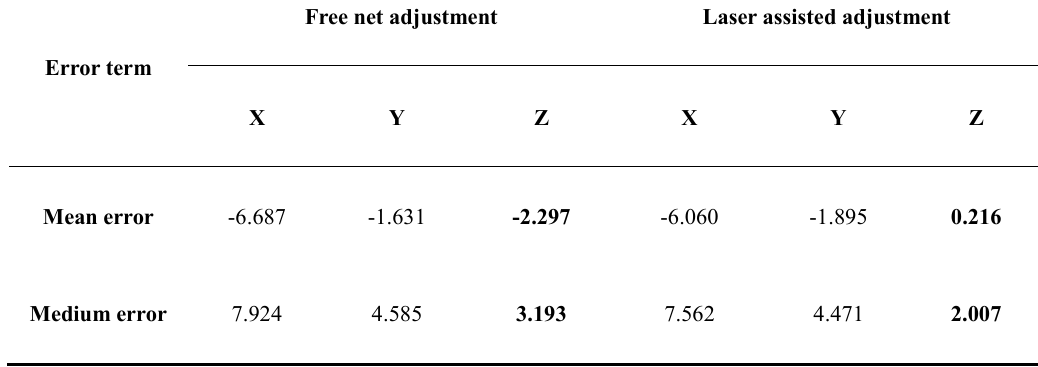
Table 3. Comparison table of adjustment residuals before and after laser point introduction in experimental